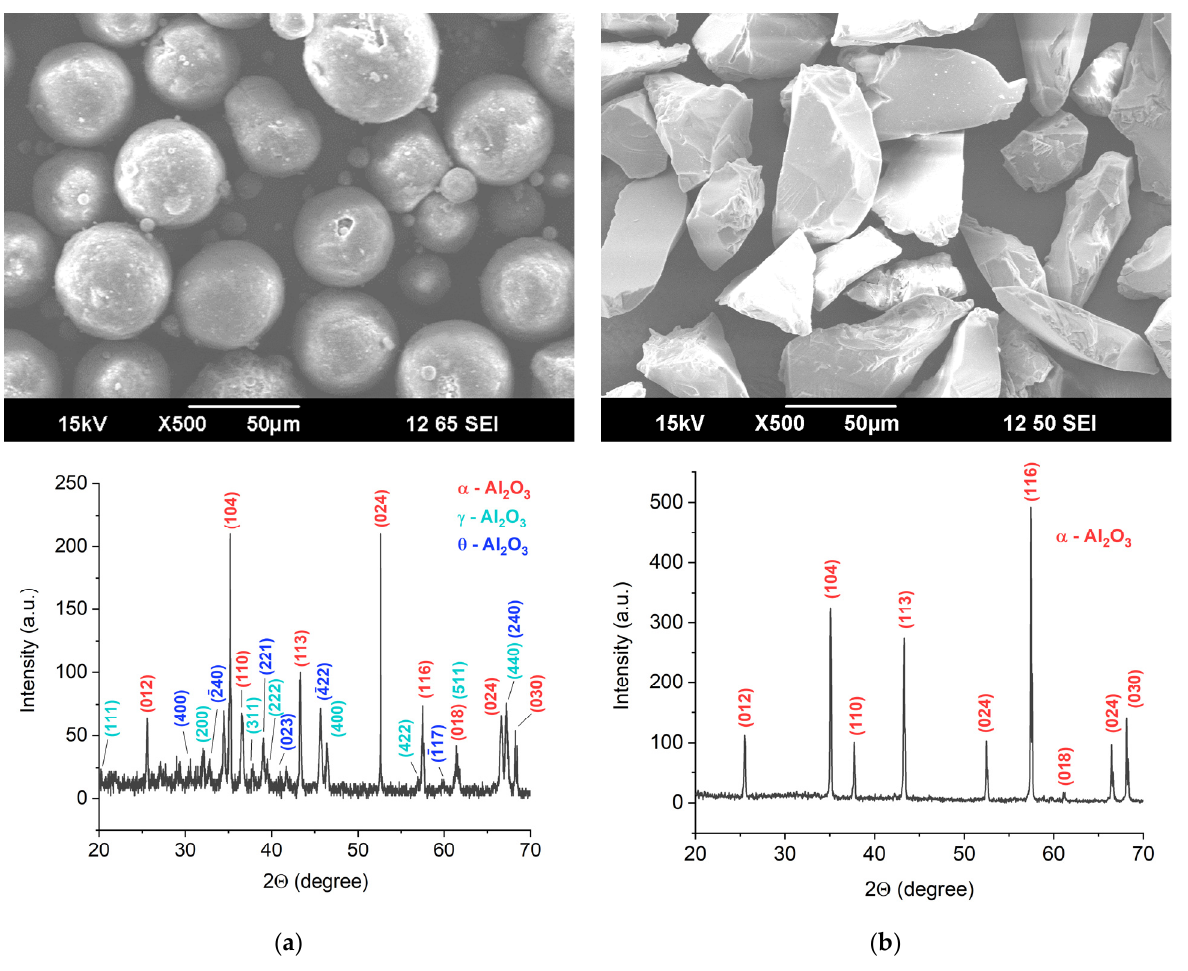
Figure 1. Morphology and phase contents of ( a ) hollow alumina microspheres and ( b ) electrocorun- dum F240.